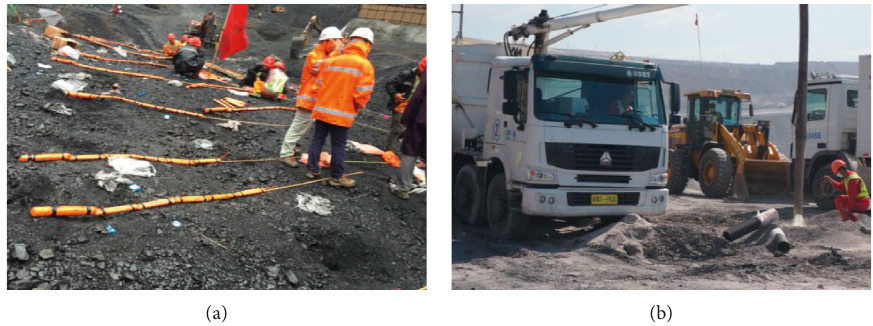
Figure 1: Scene of the charging process in drill and blast: (a) finished explosive charge; (b) semifinished charging